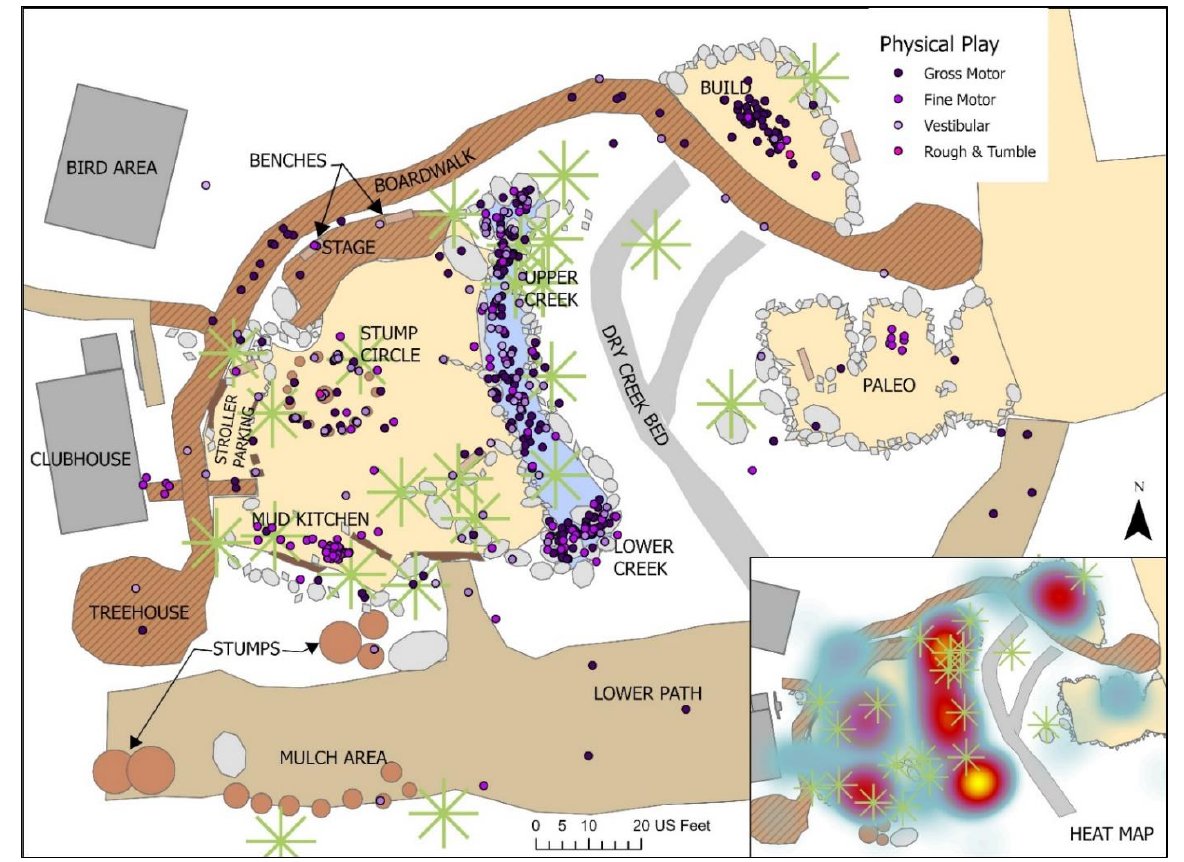
Figure 14. Behavior map of all Physical Play activities. Exploratory Play : Activities with an Exploratory component were the second most observed outdoor play type; in addition to being predominately paired with Physical play (62.4%), it was also often observed in combination with Imaginative (14.1%) and Bio play (8.0%). Exploratory-Active play was the most common subtype observed, involved in 66% of all Exploratory activities and 40% of all play events, and was heavily centered on experimenting with boats in the water (including ways to manipulate the boat or the creek environment to change its trajectory down the creek), and mud kitchen activities such as filling or stirring bowls full of mud, water, mulch and other natural loose parts (See Figure 15). Exploratory-Sensory play (in 26% of Exploratory activities, 16% of all play events) was also prominent and focused on exploring the properties of water or mud, or looking for or examining the sensory features of loose parts such as water, leaves, mulch and flowers. Sensory play was observed in diverse locations across the site, particularly where plants or other natural matter was present. Constructive play, observed in 10% of all Exploratory activities, was largely observed in the build area where children would build structures using the bamboo poles present, and in the creek where they built dams in various parts of the creek (though this was not allowed due to the sensitivity of the creek water system and was discouraged or dismantled fairly quickly by